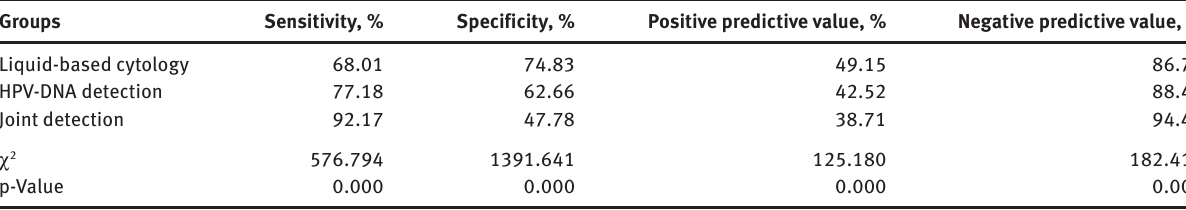
Table 2: Detection efficiency of liquid-based cytology and HPV-DNA in the age group 30–50 years.